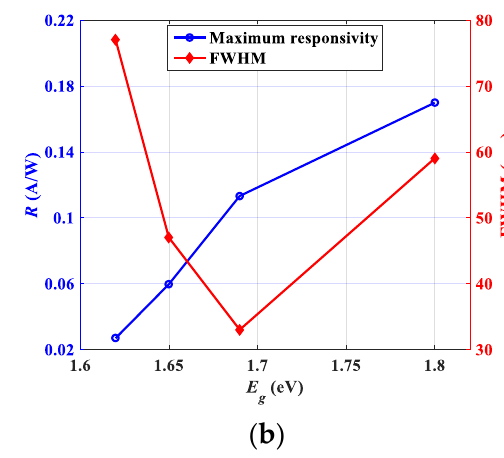
Figure 5. Impact of perovskite energy gap on ( a ) the EQE characteristics, and ( b ) peak responsivity and full width at half maximum.